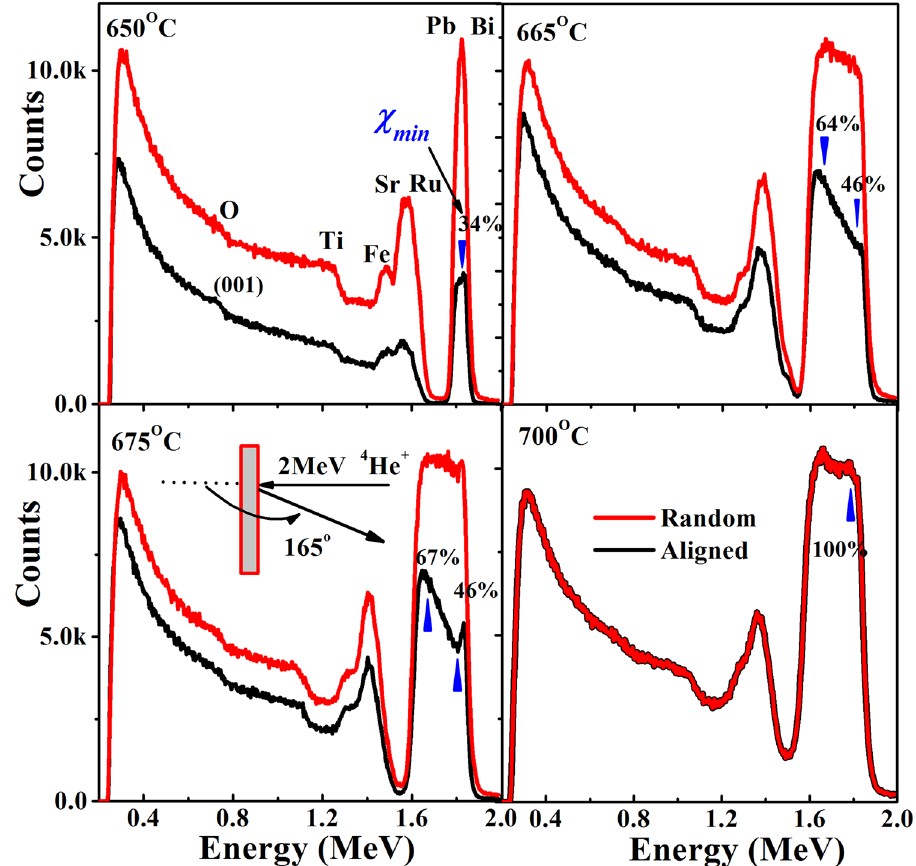
Figure 2. Random and aligned RBS spectra for (BiPb)FeO 3 /SrRuO 3 /SrTiO 3 heterostructures. Random (red) and aligned RBS spectra (along [001] direction) (black) for (BiPb)FeO 3 /SrRuO 3 /SrTiO 3 heterostructures. RBS ratio ( χ min : 34 to 100%) (blue triangle) at (BiPb)FeO 3 surfaces clearly indicates crystalline quality degradation and eventually completes an overlap of aligned to random spectra at high T g . Inset shows RBS experimental